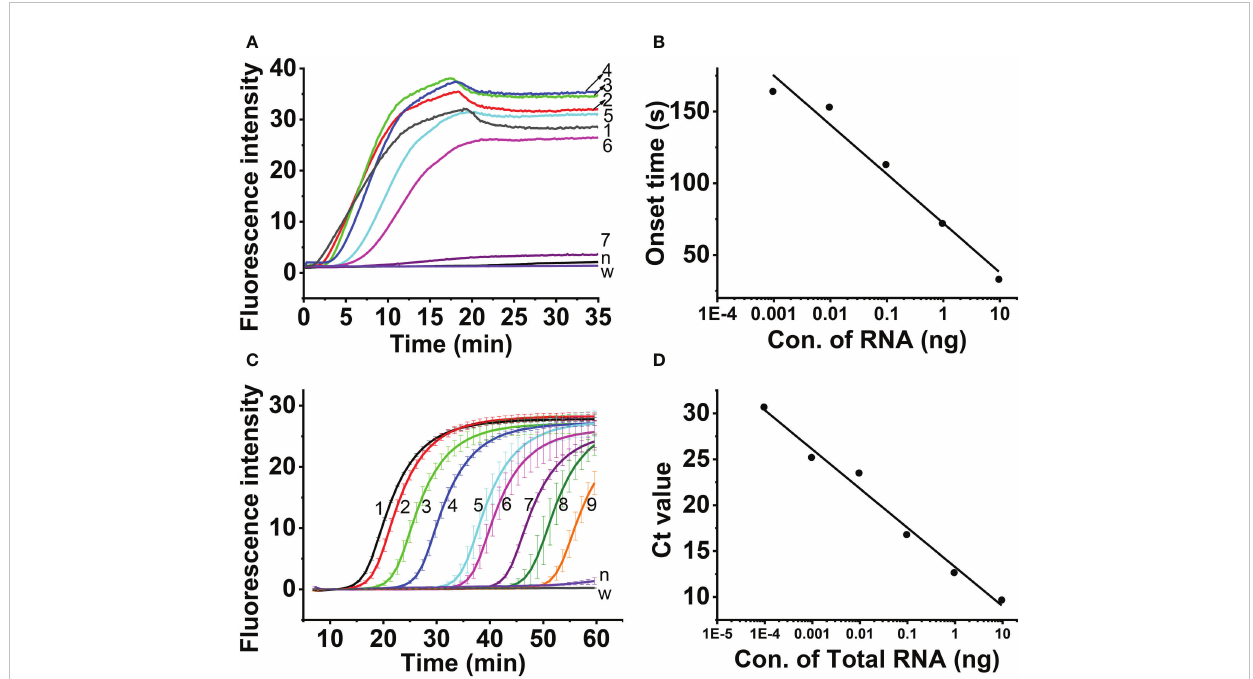
FIGURE 6 Sensitivity assessment of real-time one-step RT-RAA (A, B) and TaqMan real time RT-PCR (C, D) , Lines 1 ~ 8 indicated the amount of total RNA. 1, 96 ng; 2, 9.6 ng; 3, 0.96 ng; 4, 96 pg; 5, 9.6 pg; 6, 0.96 pg; 7, 96 fg; 8, 9.6 fg; 9, 0.96 fg; n, healthy maize plant; w, water.